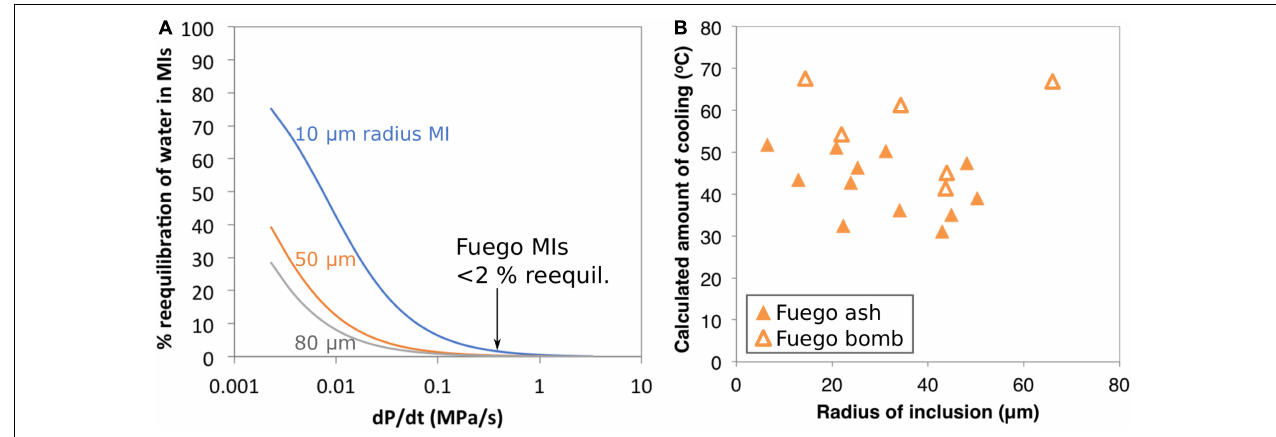
FIGURE 7 | (A) Model of diffusive water loss from olivine-hosted melt inclusions during syneruptive magma decompression. Calculations are shown for melt inclusions with radii of 10, 50, and 80 µ m, positioned 110 µ m away from the nearest edge of their host olivine crystal. The magma is assumed to ascend from 220 MPa to the surface and to contain an initial water concentration of 4.2 wt%. Parameters for this calculation are chosen based on observations of Fuego olivine-hosted melt inclusions and embayments (Lloyd et al., 2013, 2014). Water diffusivity through olivine is 2.45 × 10 - 11 m 2 s - 1 based on the Arrhenius relationship from Barth et al. (2019) and assuming 1D diffusion along the crystallographic ‘a’ direction at 1030 ◦ C. The partition coefficient for water between melt and olivine is assumed to be 0.001 and the external magma is assumed to follow a closed-system degassing path (Newman and Lowenstern, 2002). At a magma decompression rate of ∼ 0.4 MPa/s (Lloyd et al., 2014) we expect very little water loss ( < 2%) from the Fuego melt inclusions during ascent. (B) Calculated amount of cooling (i.e., the temperature implied by the maximum measured MgO minus the temperature implied by the minimum measured MgO in each melt inclusion) versus inclusion radius. The lack of a clear negative correlation between these variables supports the conclusion of the calculations in (A) that the Fuego inclusions lose minimal water during magma ascent. The bomb-derived inclusions have higher calculated temperature drops on average than the ash-derived inclusions, consistent with slower cooling of the bomb-derived inclusions to a lower MgO closure temperature and/or post-eruptive water-loss-driven olivine crystallization.